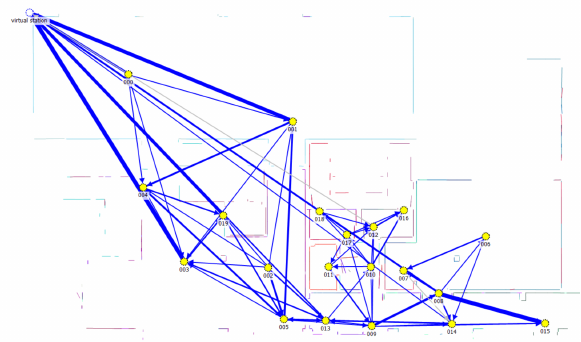
Figure 9. Result topology in Scantra with virtual station as